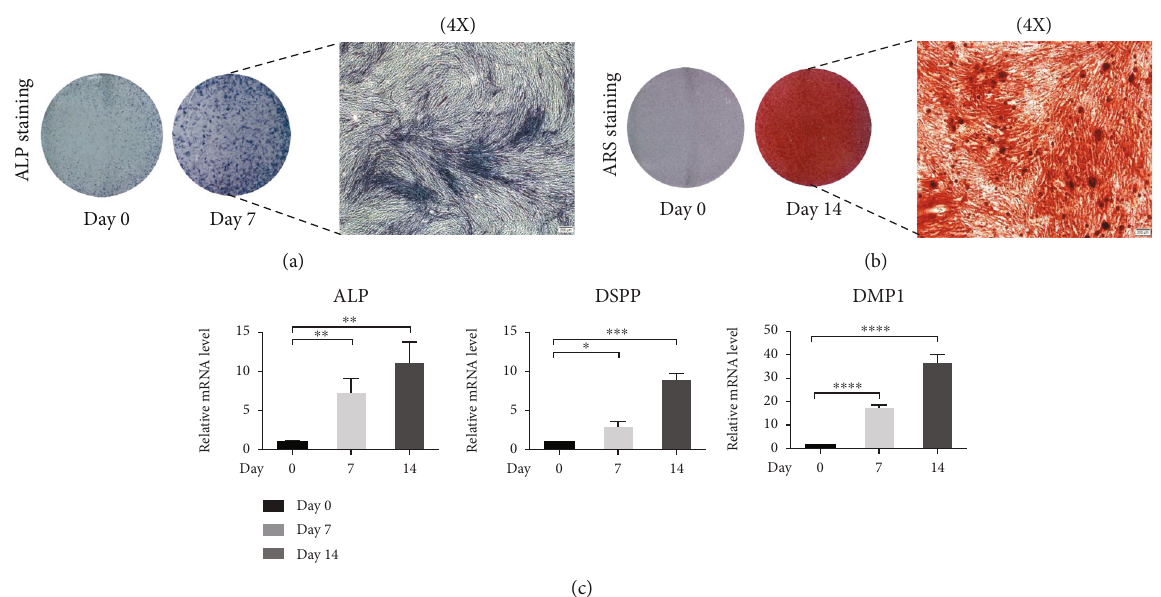
Figure 1: Odontogenic potential of stem cells from human exfoliated deciduous teeth (SHED) during di ff erentiation on day 0, day 7, and day 14. (a) ALP staining of SHED on day 0 and day 7. (b) ARS staining of SHED on day 0 and day 14. Scale bar = 200 μ m . ALP: alkaline phosphatase staining; ARS: alizarin red S staining. (c) Expression levels of odontogenic markers ALP, DSPP, and DMP1 are signi fi cantly increased during di ff erentiation on day 7 and day 14. Data were expressed as the mean ± standard deviation (SD) of three experiments per group, ∗∗ p < 0 : 01 , ∗∗∗ p < 0 : 001 , and ∗∗∗∗ p < 0 : 0001